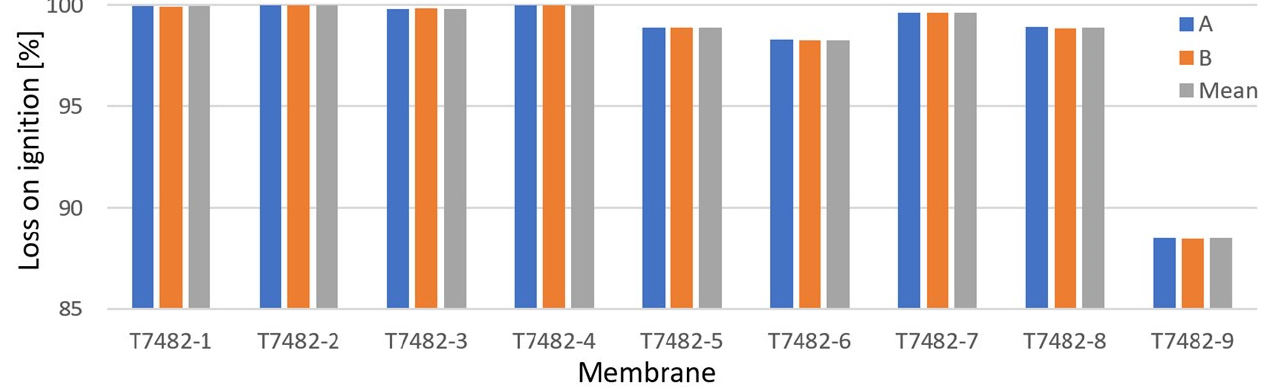
Figure 16. Loss on ignition for the samples examined.